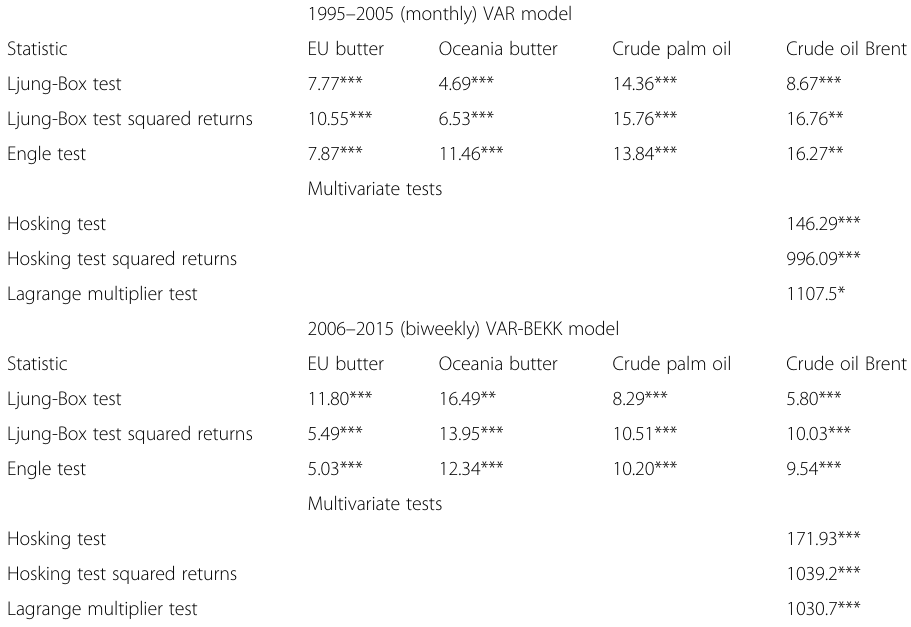
Table 3 Diagnostic tests for the residuals of the VAR model (1995 to 2005) and VAR-BEKK model (2006 to 2015) 1995 – 2005 (monthly) VAR